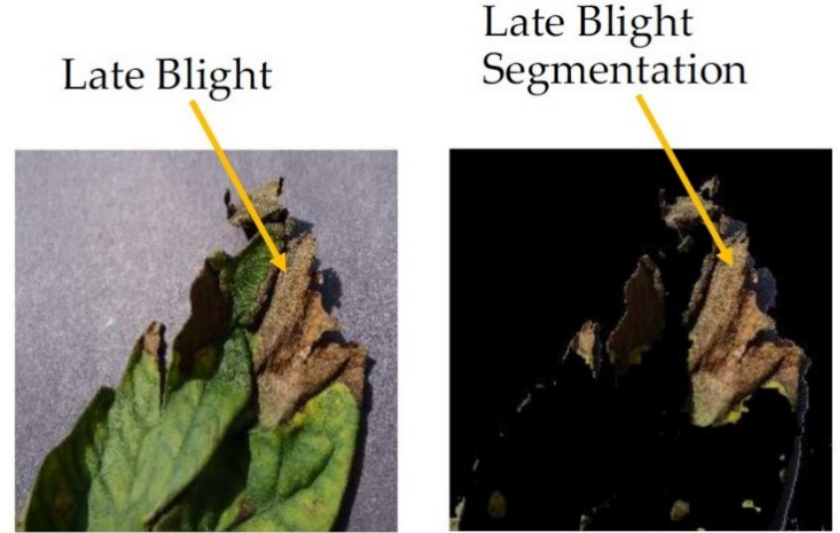
Figure 6. Segmentation of lesion on a tomato leaf infected by Late Blight.